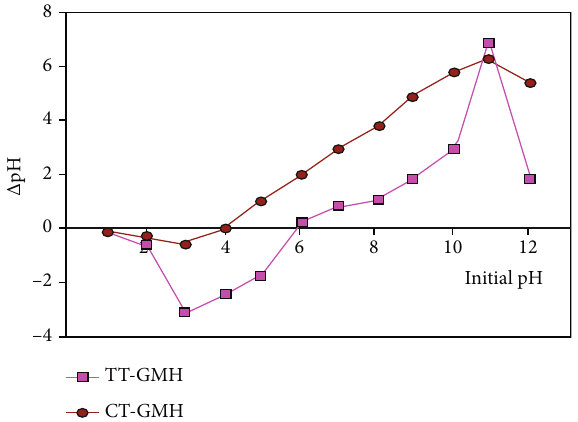
Figure 1: Point of zero charge of adsorbents TT-GMH and CT-